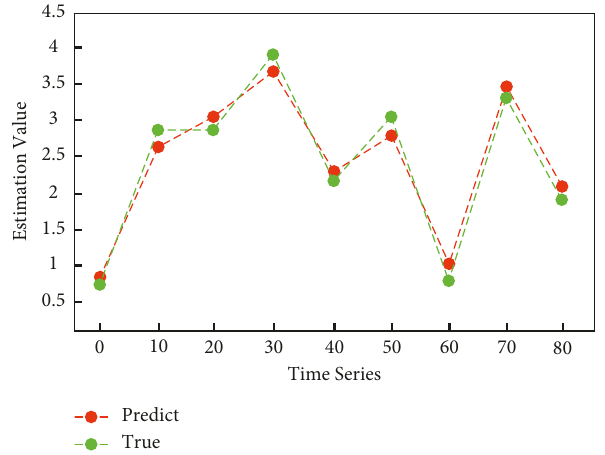
Figure 8: Comparison results of predicted value and real value of the